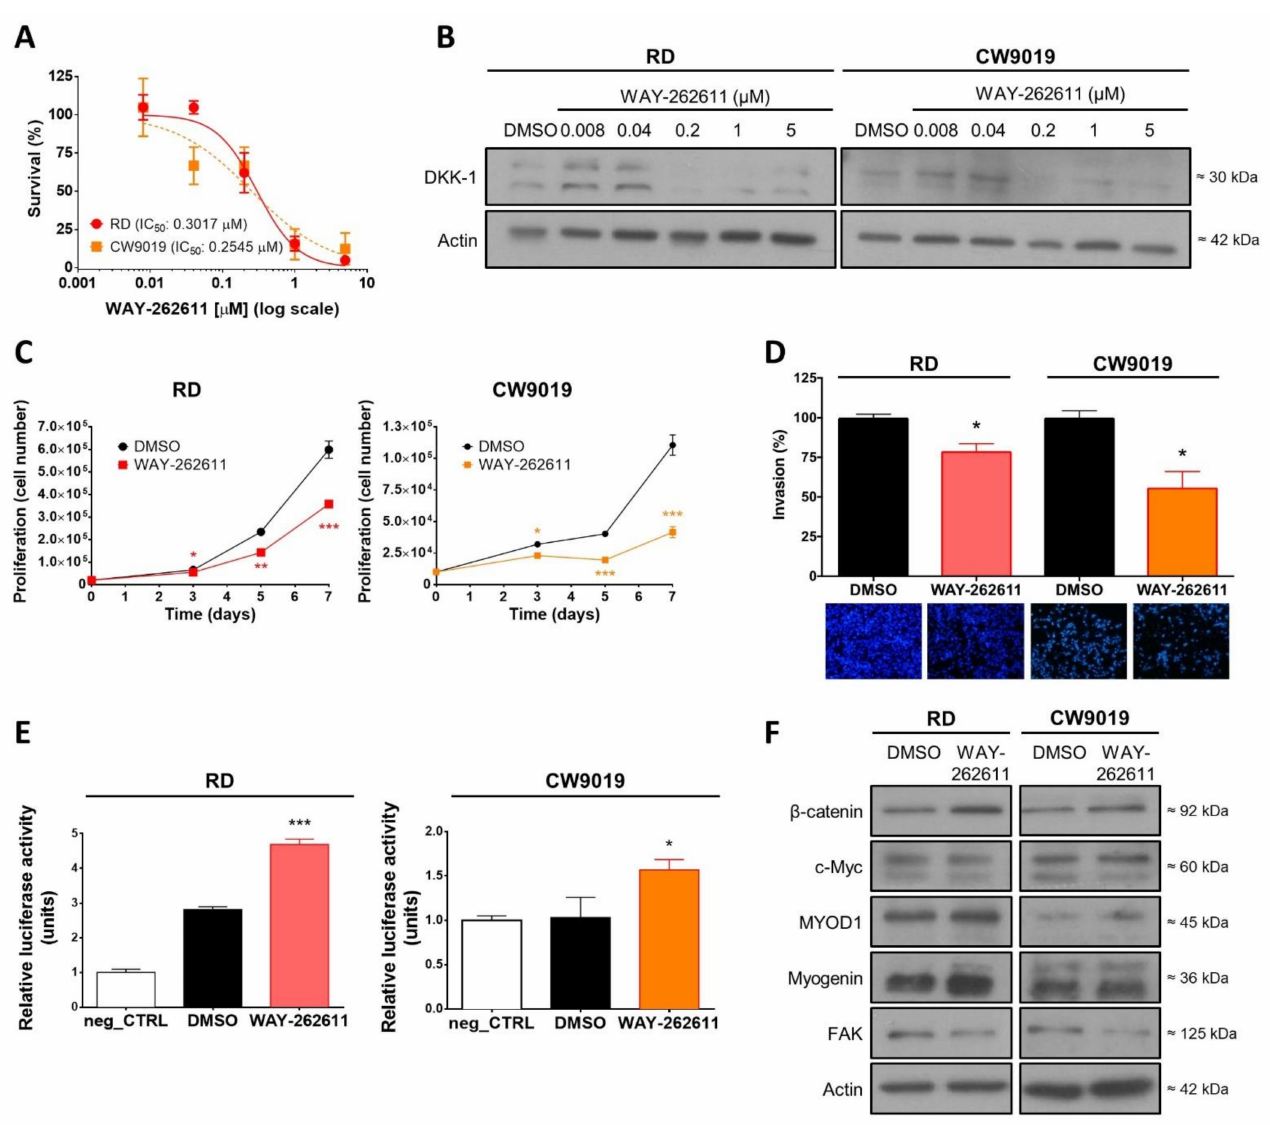
Figure 3. Pharmacological inhibition of DKK-1 by the compound WAY-262611. WAY-262611 treatment was carried out in both RMS cell lines (RD and CW9019). ( A ) The IC50 determination was assessed by a crystal violet proliferation assay after 72 h of WAY-262611 treatment. ( B ) DKK-1 protein expression after treatment with increasing concentrations of WAY-26211 was assessed by Western blot. ( C ) Proliferation over 7 days and ( D ) invasion analysis were carried out in both cell lines in presence of WAY-262611 at 0.2 µ M. ( E ) β -catenin promoter activity was assessed by luciferase assay. ( F ) β -catenin levels, and those of other protein markers, were assessed by Western blot after treatment with WAY-262611 (0.2 µ M). * p < 0.05, ** p < 0.01 and *** p <